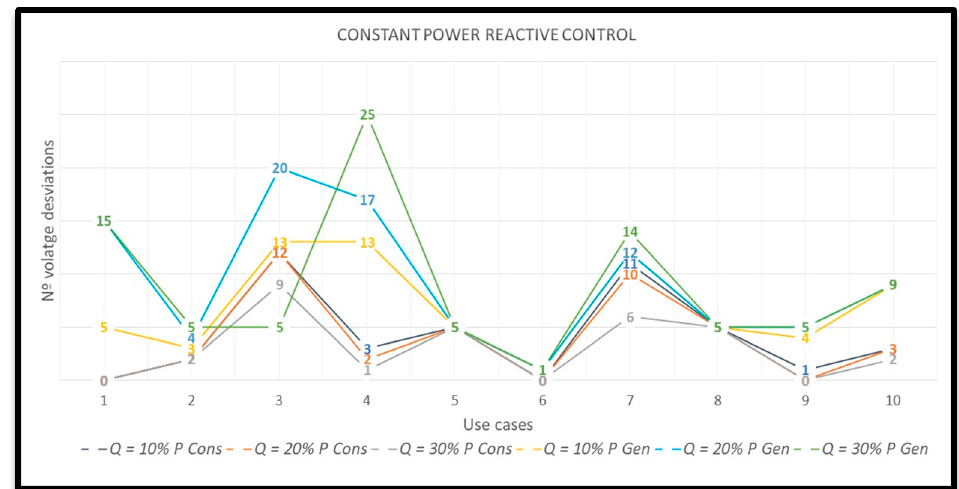
Figure 7. Constant reactive power control: Voltage deviations. (More information see Table A4 in Appendix C).